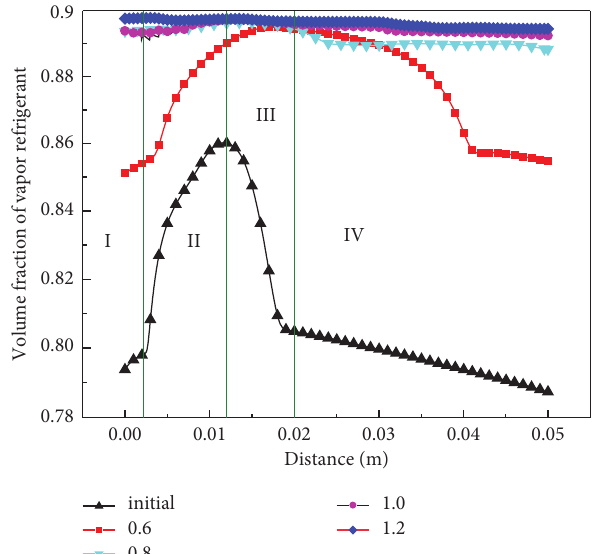
Figure 12: Local refrigerant vapor rate distribution at the outlet of the